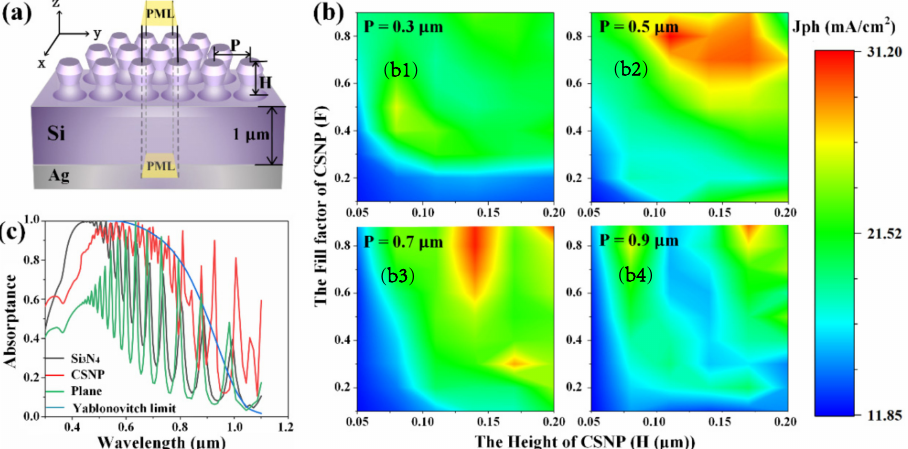
Figure 5. The simulation of a solar cell: ( a ) Simulation model of the CSNP thin film Si solar cell. ( b ) Relationships between the parameters of CSNP and J ph of solar cell at different periods for ( b1 ) 0.3 µ m, ( b2 ) 0.5 µ m, ( b3 ) 0.7 µ m, and ( b4 ) 0.9 µ m. Height ranges from 0.05 µ m to 0.2 µ m with a step size of 0.03 µ m. Fill factor ranges from 0.1 to 0.9 with a step size of 0.1. ( c ) Absorptance calculation results for 1 µ m thick solar cells under different architectures. CSNP with P = 0.5 µ m, F = 0.8 and H = 0.11 µ m was used and the thickness of Si 3 N 4 has been optimized. The absorptance of Yablonovitch light capture limit of 1 µ m thick c-Si was used for